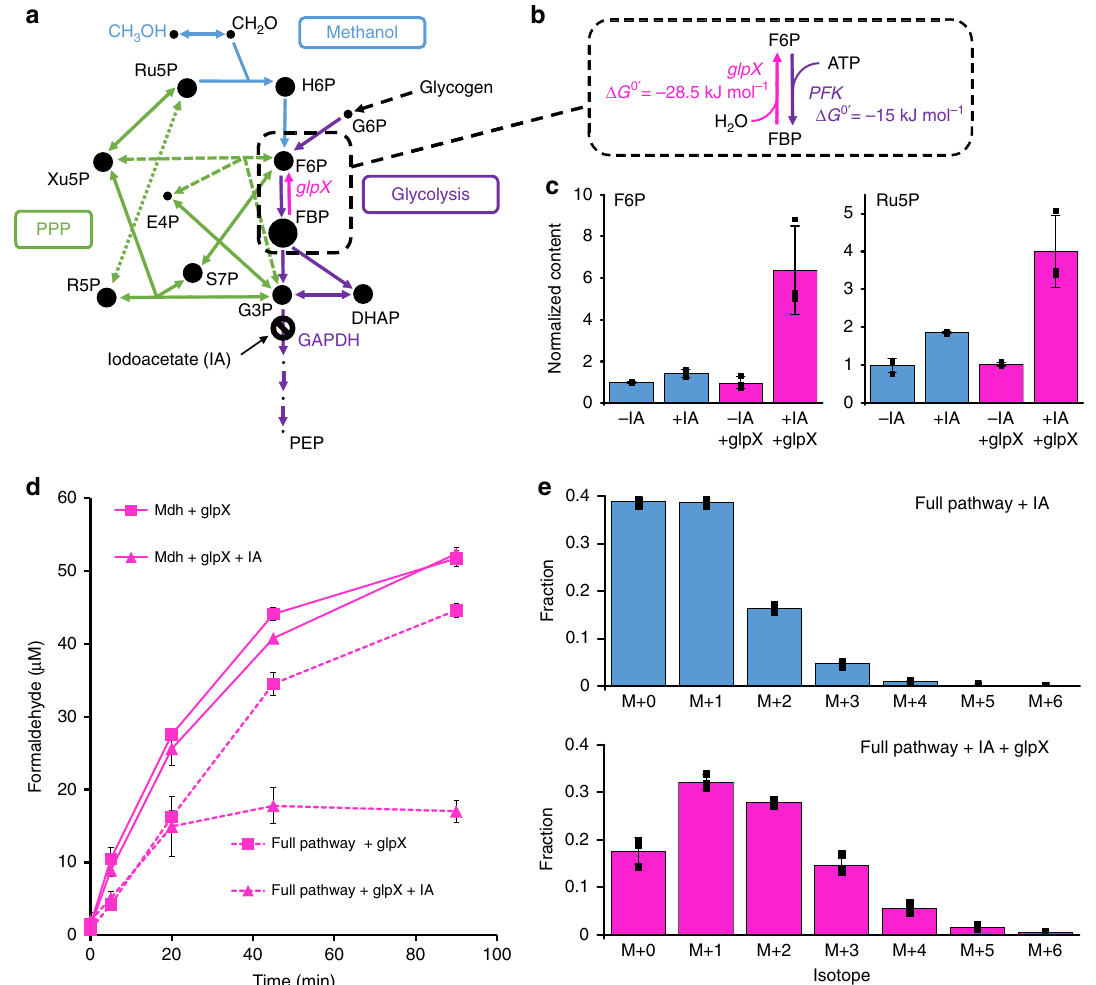
Fig. 4 Iodoacetate coupled with glpX overexpression increases Ru5P concentration and improves cyclic formaldehyde assimilation. a Metabolic pathways in methanol metabolism, showing the blockage of glycolysis by iodoacetate (IA), and the minor gluconeogenic FBPase encoded by glpX . Dot sizes indicate relative pool sizes after IA addition in cells expressing glpX compared to untreated cells without glpX overexpression. b FBPase catalyzes the irreversible hydrolysis of FBP to F6P ( Δ G 0 ′ = − 28.5 kJ mol − 1 ), potentially allowing the conversion of the large FBP pool resulting from IA-mediated inhibition into F6P, the entry point for the transaldolase and transketolase reactions that replenish the PPP intermediates. c Relative concentrations of F6P and Ru5P upon treatment with IA in cells with (pink) or without (blue) glpX overexpression. d Formaldehyde levels after addition of 250 mM methanol to starved cells of E. coli MG1655(DE3) Δ frmA . Solid lines denote cells expressing only Mdh, whereas dashed lines indicate cells expressing the full pathway (Mdh, Hps, and Phi). Pink lines denote cells expressing glpX . Triangles indicate cells treated with IA, squares indicate untreated cells. e Isotopic analysis of fructose 6- phosphate extracted from IA-treated cells with (pink) or without (blue) glpX overexpression that were treated with 250 mM 13 CH 3 OH. Error bars represent s.d. of n = 3 biological replicates (three individual